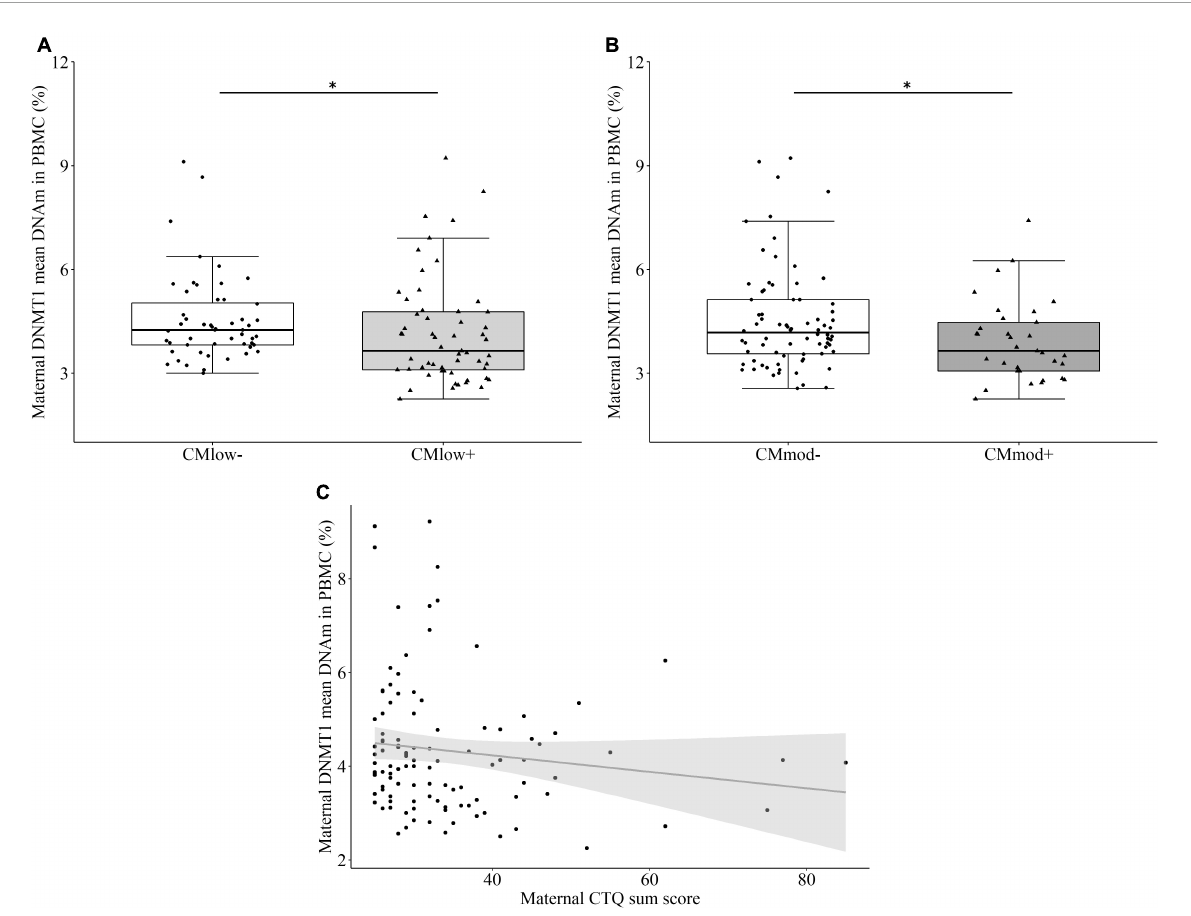
FIGURE1 DNA methyltransferase 1 ( DNMT1 ) mean DNA methylation (DNAm) and relative gene expression in peripheral blood mononuclear cells (PBMC) of the mothers. (A) Mothers with none to mild CM experiences ( CM low - ) had higher DNMT1 mean DNAm compared to mothers with at least low CM experiences (CM low + ; p = 0.013). (B) Mothers with none to low CM experiences (CM mod - ) had higher DNMT1 mean DNAm compared to mothers with at least moderate CM experiences (CM mod + ; p = 0.040). (C) DNMT1 mean DNAm had a negative trend level correlation